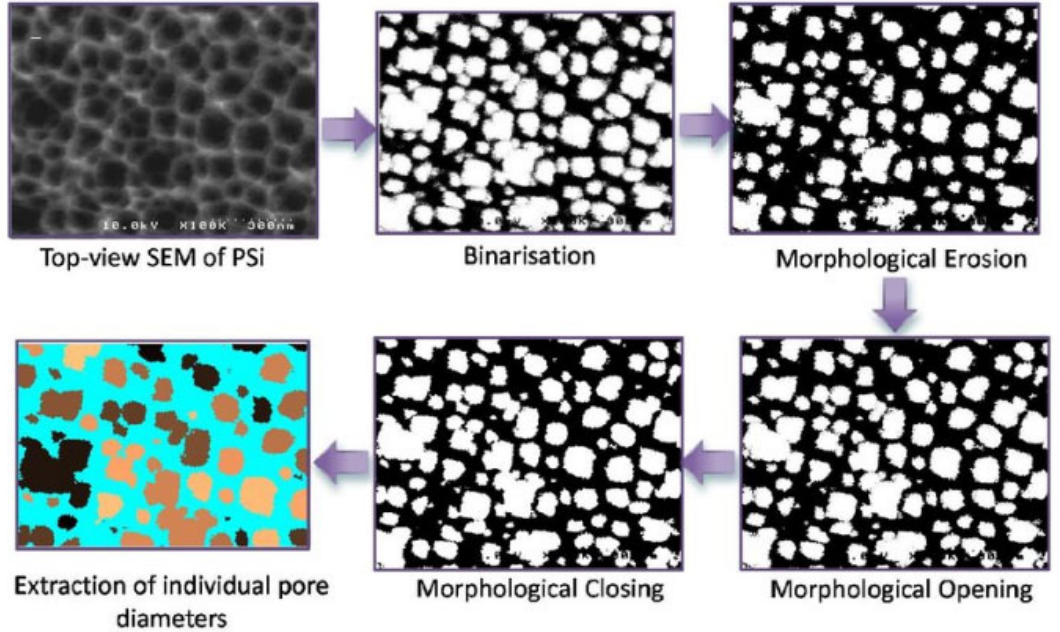
Figure 2. Image processing of SEM data to calculate the pore size profile of a silicon film using MATLAB [18].